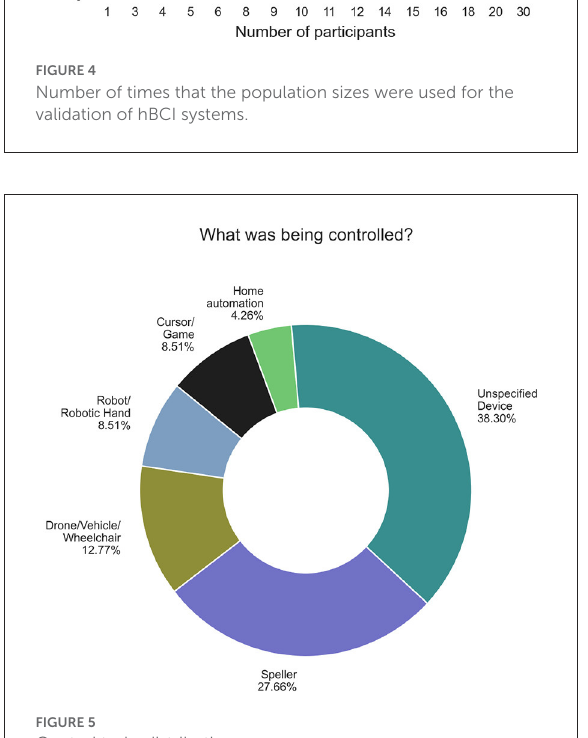
FIGURE5 Control tasks distribution.